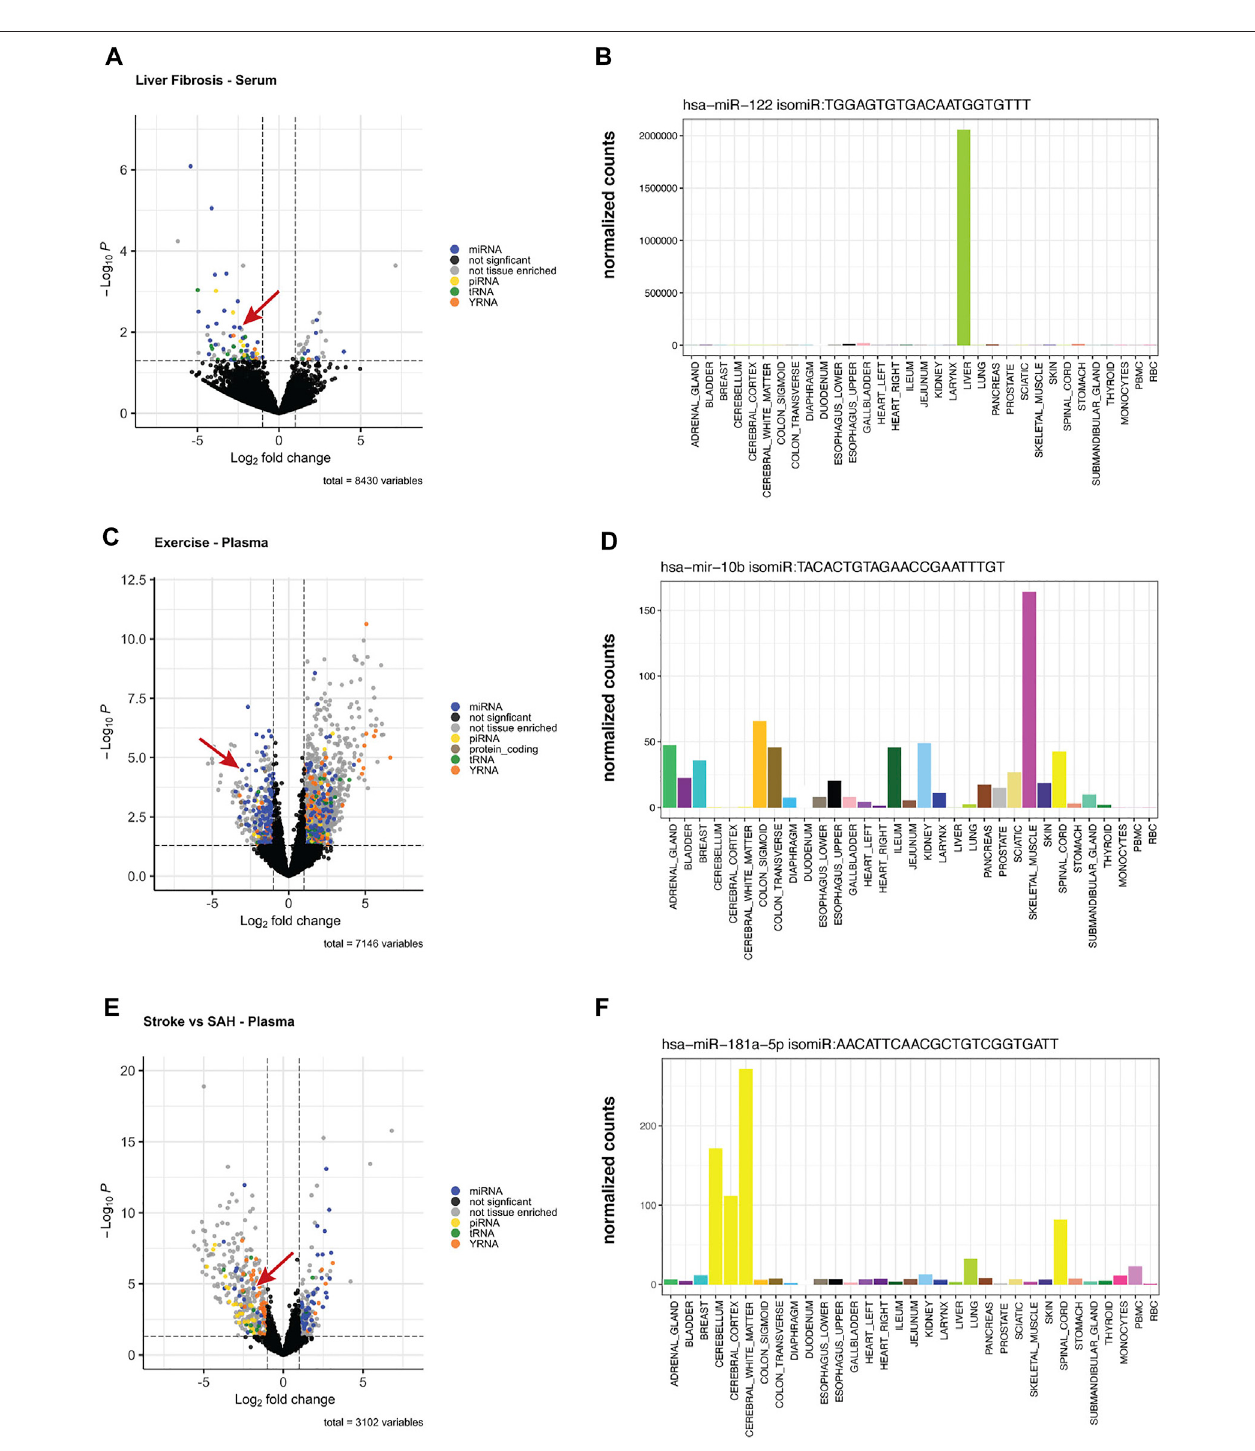
FIGURE 9 | Differentially Expressed Tissue-Elevated Sequences. We examined three different conditions for differentially expressed sequences: (A) displays the differentially expressed tissue-elevated sequences found in blood samples from Hepatitis C patients with liver fi brosis stage 1 or stage 4. Panel (B) is a tissue-elevated isomiR that is highly expressed in liver. (C) are samples taken from participants before and after exercise, and the expression level of a muscle-elevated isomiR across tissues (D) . The fi nal example is from a comparison of plasma samples taken from individuals that had either an ischaemic stroke or a subarachnoid hemorrhage, Panel (E) . In Panel (F) , we selected a CNS-elevated isomiR of miR-181-5p to illustrate tissue-elevation.